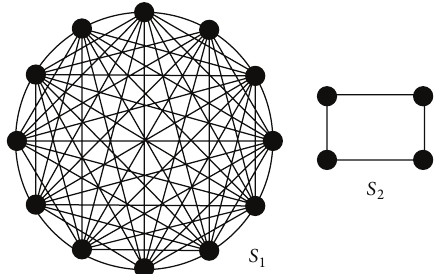
Figure 5: The complete graph 𝑆 1 and ring structure 𝑆 2